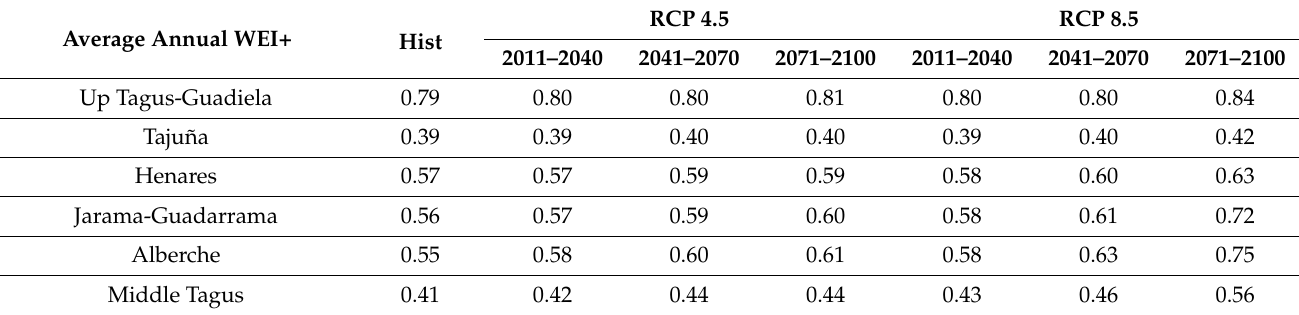
Table 3. Average annual WEI+ values under future